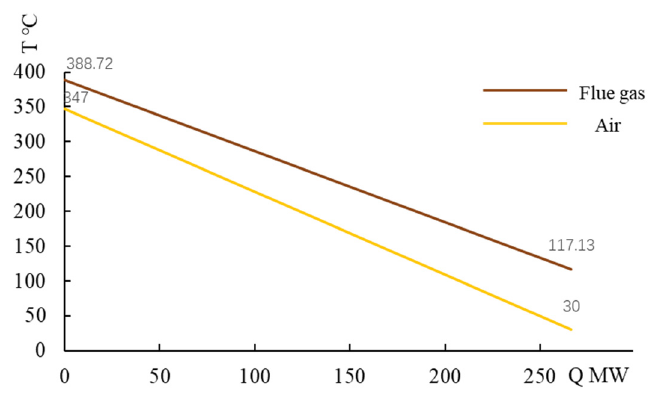
Figure 2. Heat transfer curve of air preheater.